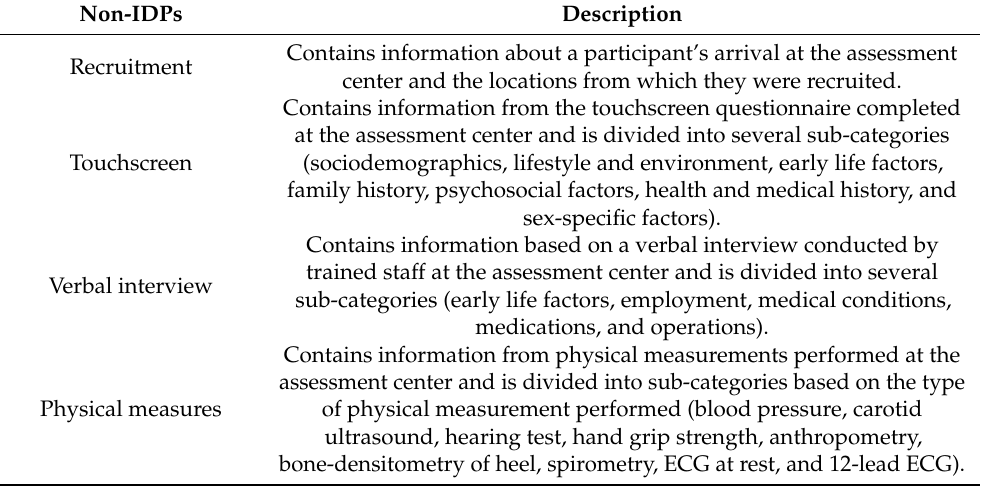
Table 3. Description of